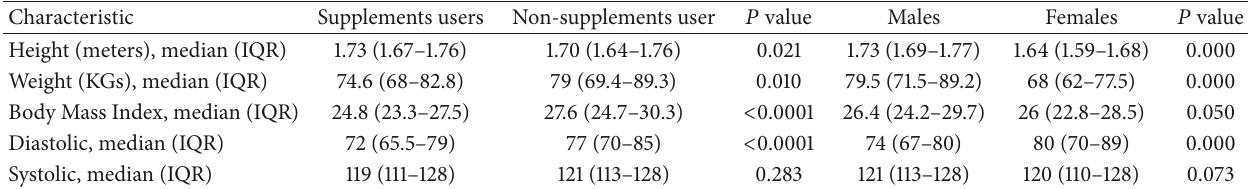
Table 3: Anthropometric measurement and blood